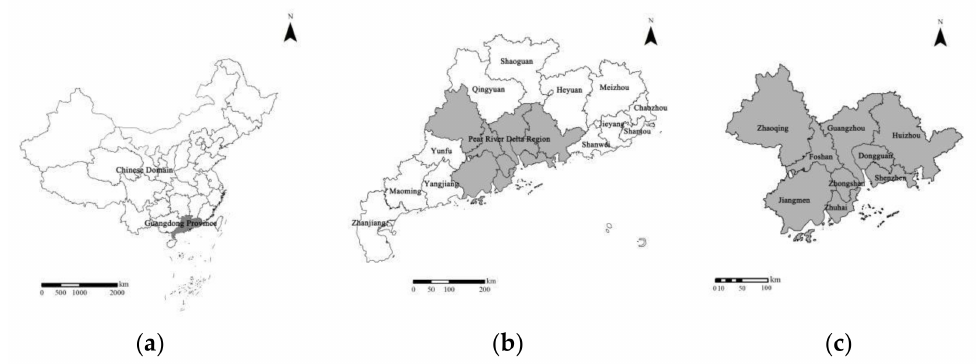
Figure 1. Study area: The Pearl River Delta: ( a ) China; ( b ) Guangdong; ( c ) The Pearl River